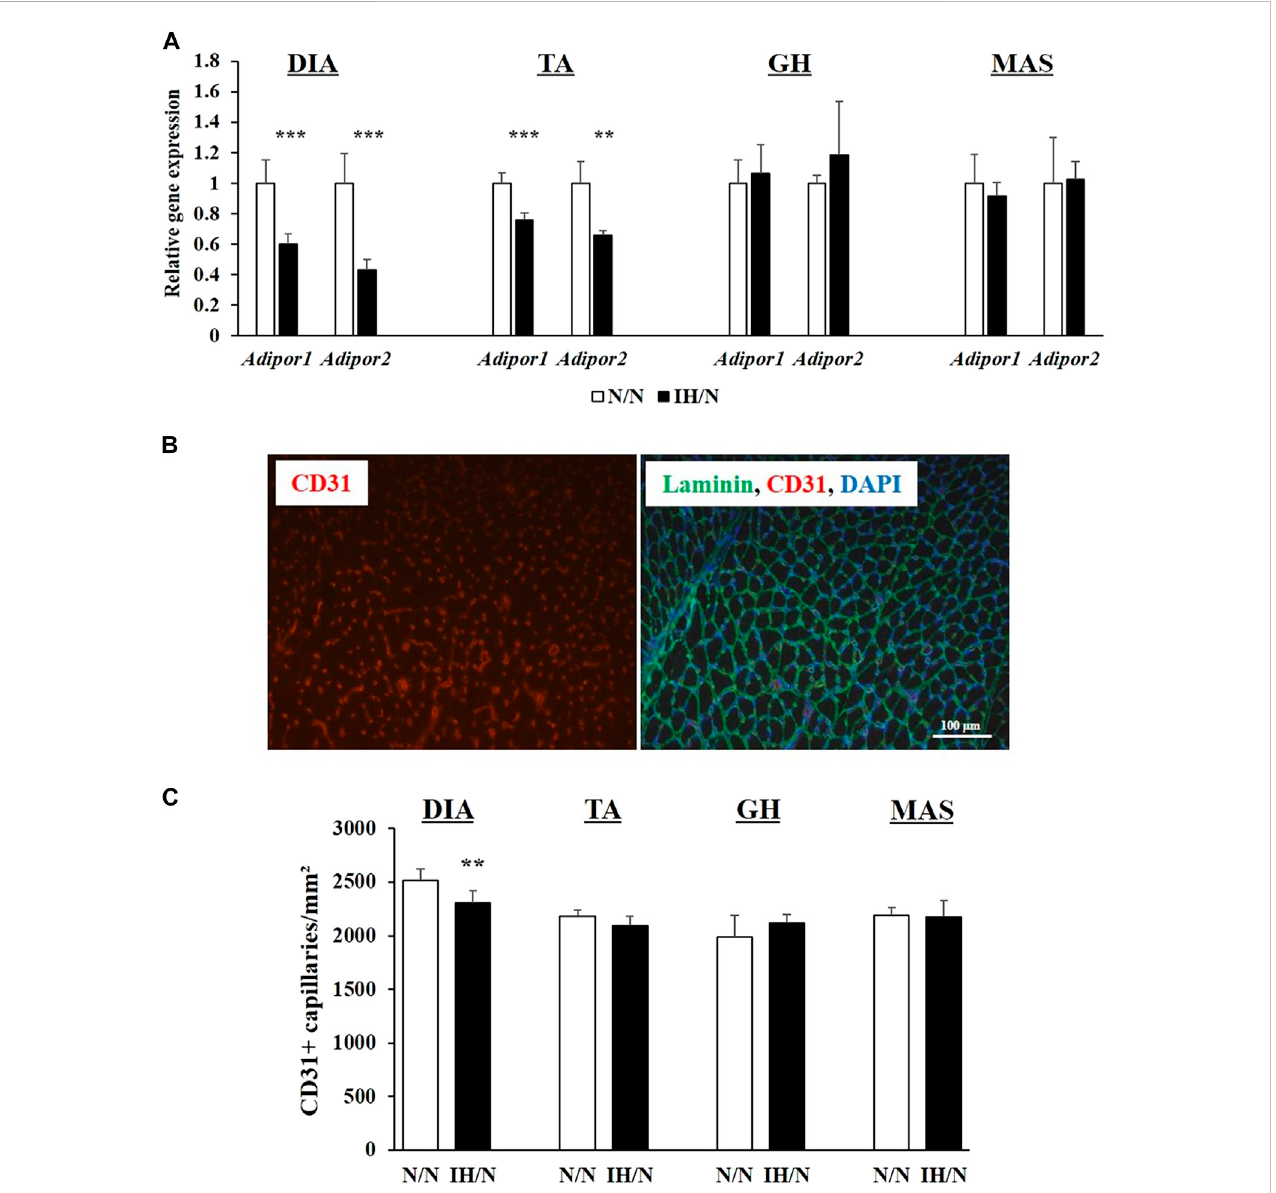
FIGURE 8 Quantitative PCR analysis of genes encoding adiponectin receptors, and quanti fi cation of capillary numbers per muscle area (mm 2 ). (A) Relative gene expression of Adipor1 and Apipor2 in the DIA, TA, GH, and MAS muscles, normalized by Actb and shown as fold increase of the N/N group. (B) Immunohistochemical staining for CD31 (red) and a merged image with laminin (green) and DAPI (blue) from the TA muscle. Bar represents 100 µm. (C) Number of capillaries per muscle area (mm 2 ). Results are presented as mean ± SD ( n = 6) ** p < .01, *** p <